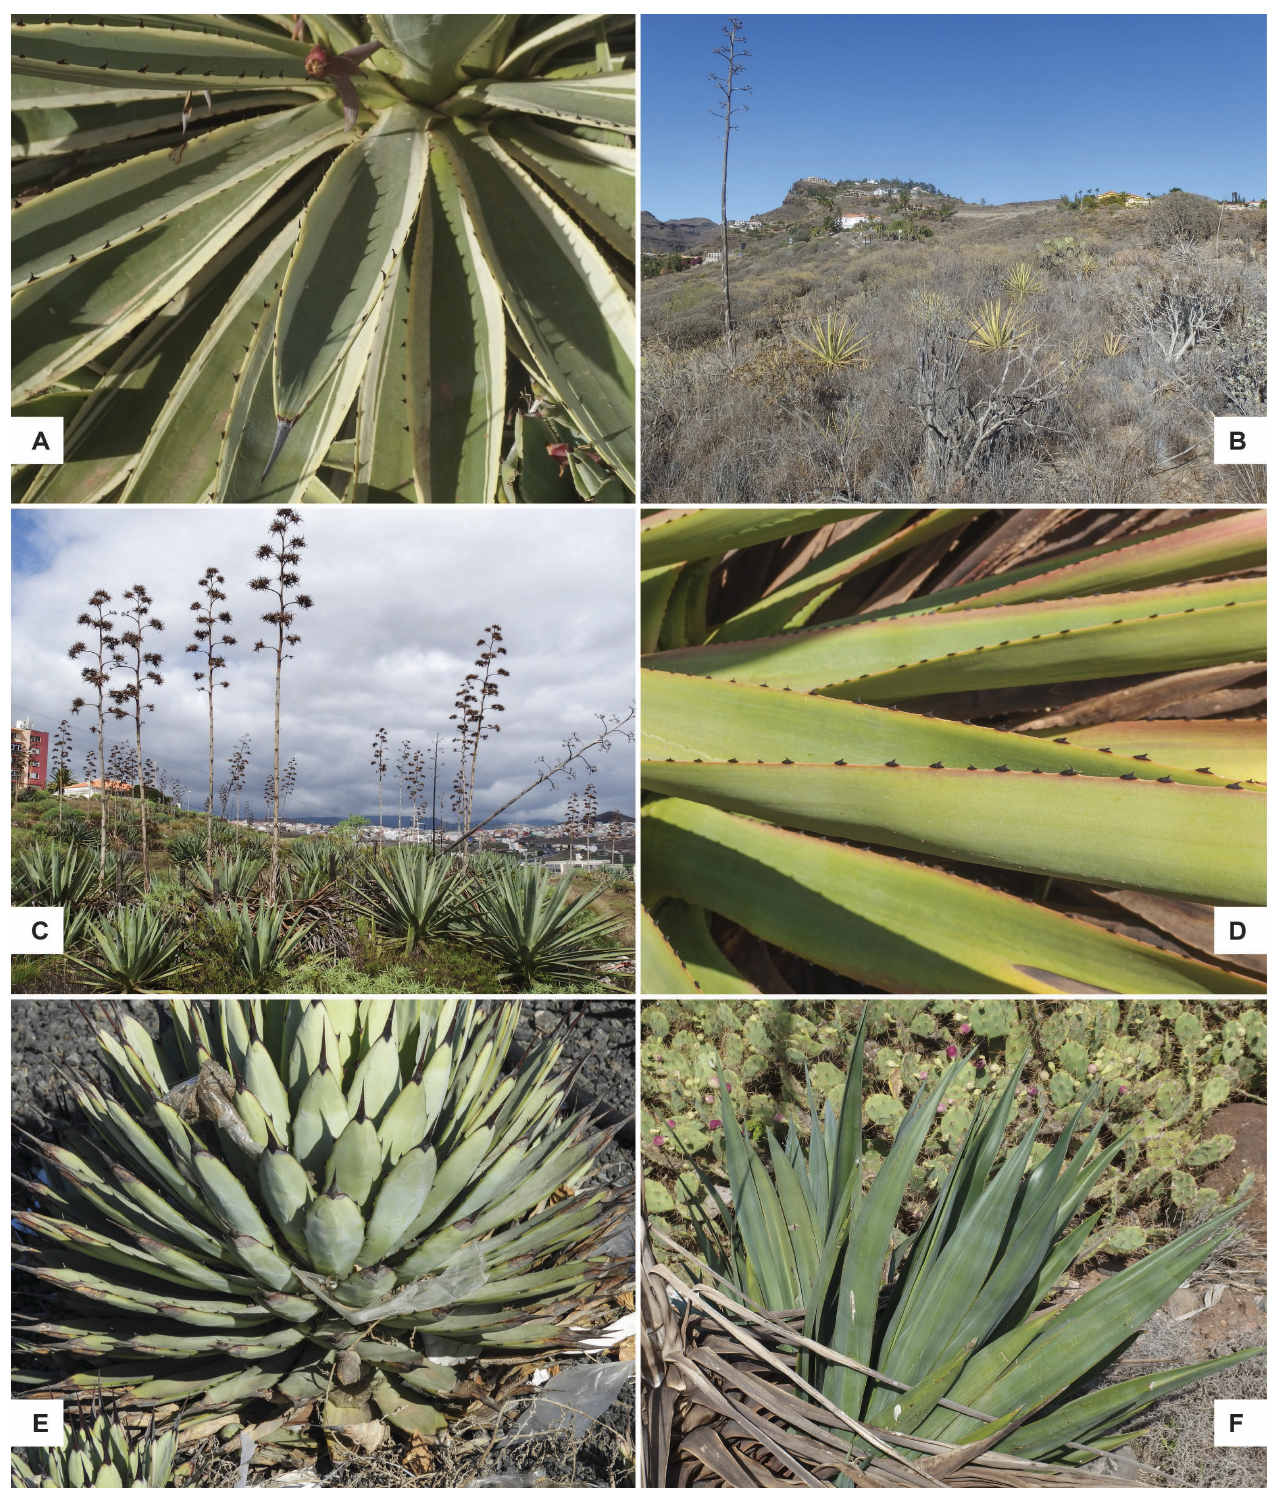
Figure 3 – A . Agave angustifolia , Güímar (T), January 2017. This form with variegated leaves (var. marginata ) is most frequently cultivated as ornamental. B . Idem, San Bartolomé de Tirajana (Monte León) (C), December 2017. In this population inflorescences are not bulbiliferous although they usually are in this species. C . A. fourcroydes , Santa Cruz de Tenerife, Santa Maria del Mar (T), November 2014. Inflorescences are very bulbiliferous in this species. D . Idem, Güímar (T), January 2017. Detail of leaf spination. E . A. macroacantha , La Oliva (F), May 2018. The blackish spines contrast a lot with the pale foliage. F . A. sisalana , Santa Lucía de Tirajana, Pozo Izquierdo (C), November 2015. Leaf margins are smooth in the typical variety of this species. Photographs: A–D, F by F. Verloove; E by E.